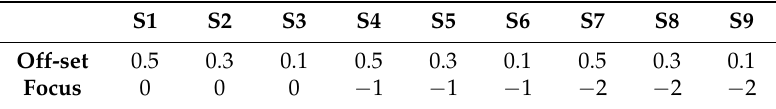
Table 3. Off-set and laser focus are in mm.